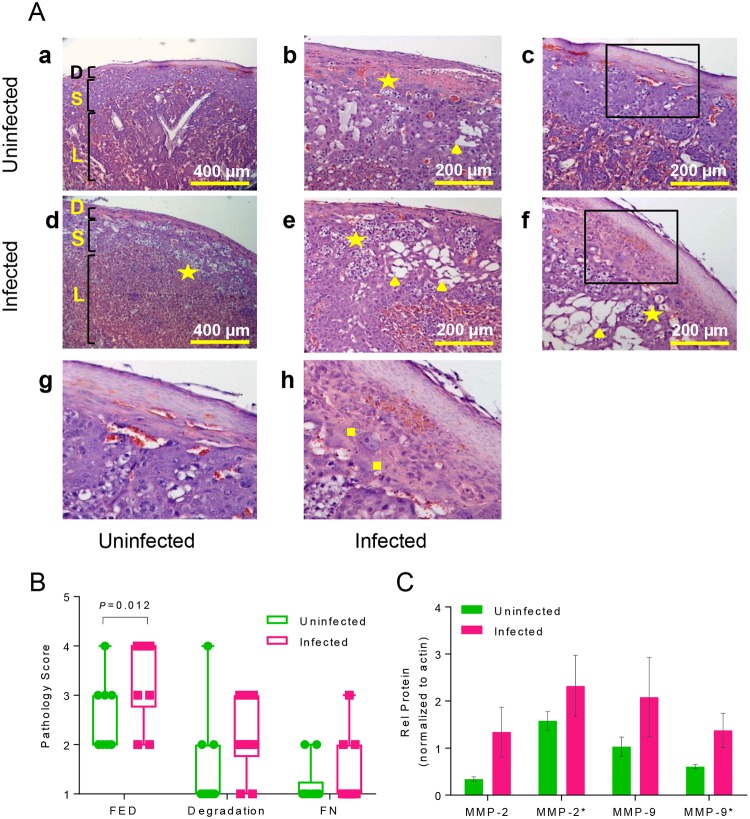
Infection damages placental architecture and increases activation of structural protein degrading matrix metalloproteinases (MMPs).A. Placentas from uninfected [a, b, c, g] (N = 8) and infected [d, e, f, h] (N = 8) pregnant mice (E16) were embedded in paraffin, sectioned in 4 μM, H&E stained and imaged with a Zeiss brightfield microscope. Infection increases gaps within the spongiotrophoblast layer (S) between the decidual layer (D) and the placental labyrinth (L) [a, d; 10x]. Gaps are marked by fetal endothelial nuclei suspended in tissue [stars] and empty space [triangles] distinct from maternal blood sinuses and fetal blood vessels [d, 10x; b, e, f, 20x]. Fibrinoid necrosis [squares] beneath the decidual layer was increased in placentae from infected mice [h, inset of box in f] compared to uninfected mice [g, inset of box in c]. B. Histology slides were randomized prior to imaging and scored blindly for the incidence of fetal endothelial death (FED; N = 10, p = 0.012), degradation of the spongiotrophoblast layer (Degradation; N = 10, p>0.05), and fibrinoid necrosis (FN; N = 10, p>0.05). C. Protein expression of matrix metalloproteinases (MMP-2, MMP-9; active forms denoted with *) in placentas in uninfected and infected mice at E16 quantified by Western blot. Two-way ANOVA: protein maturation, p = 0.064, ns; infection, p = 0.007, **.